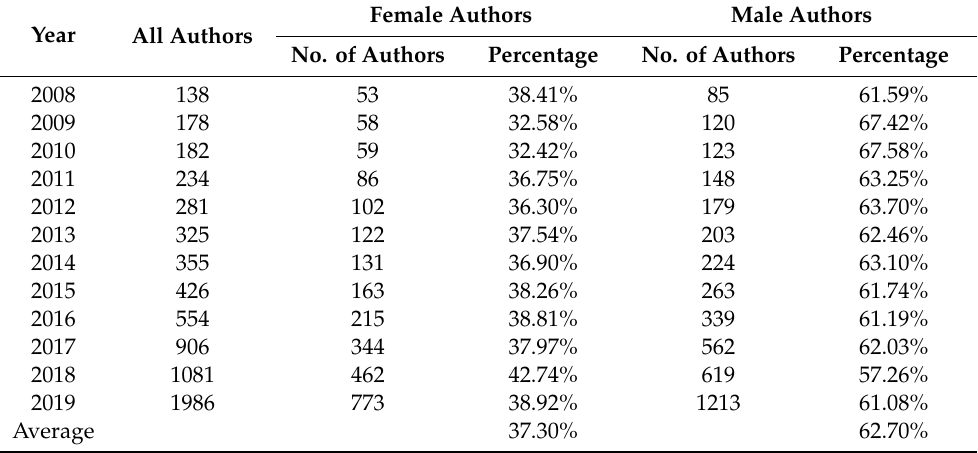
Table 2. Number of authors participating in Social Sciences and Humanities research by gender during the period from 2008–2019 (last updated 30 April 2020).